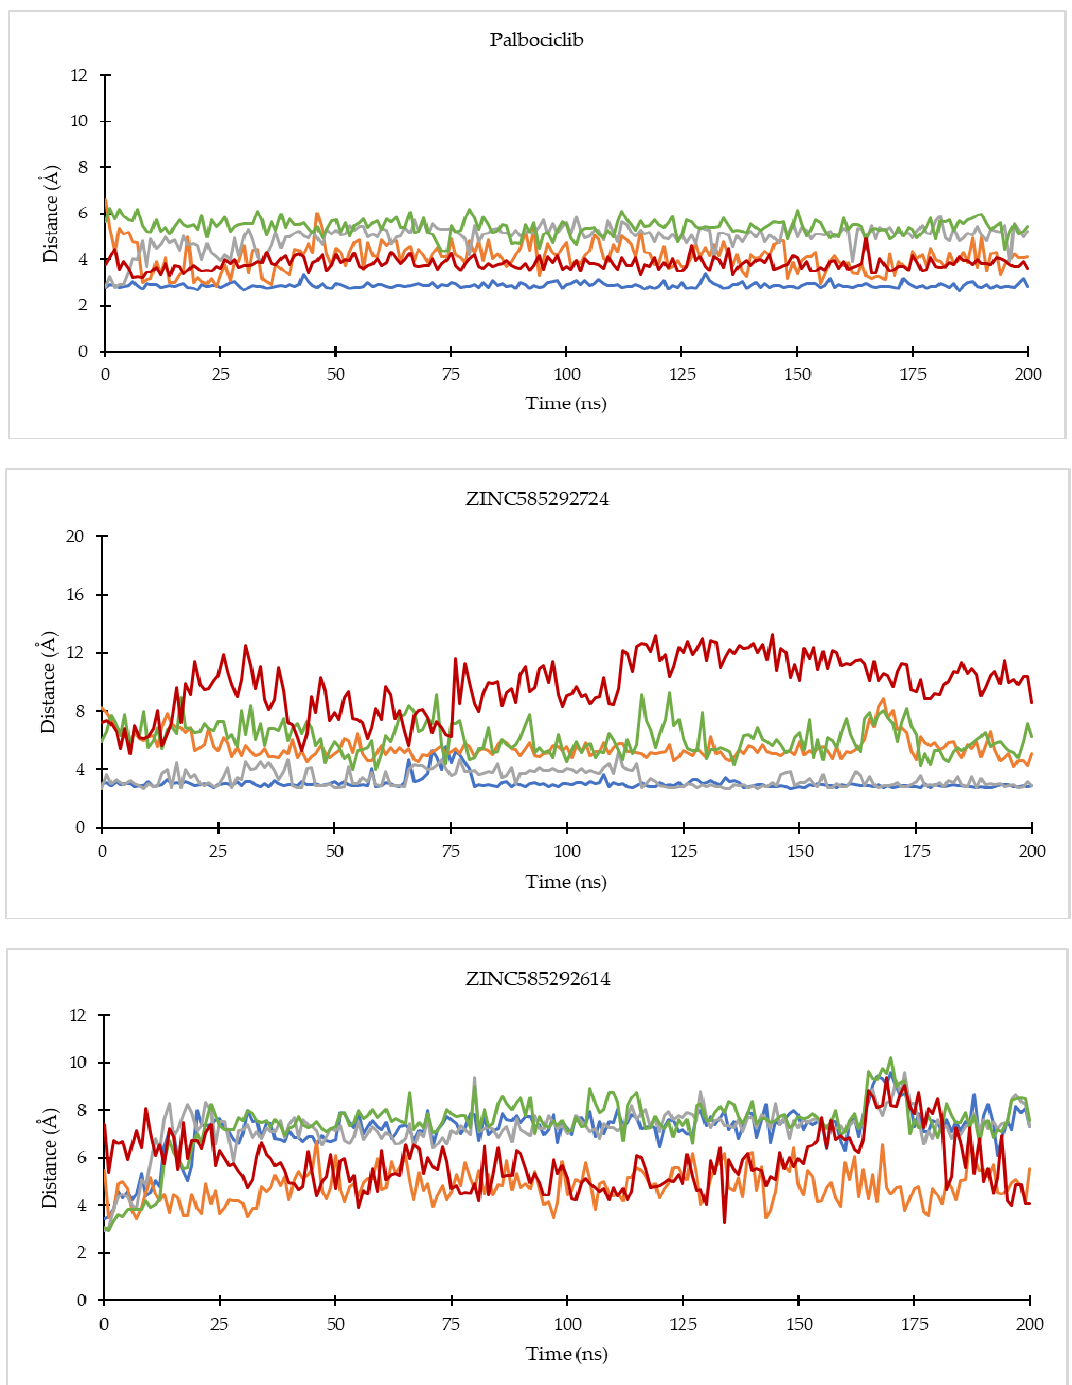
CDK6 (Figure 9), all compounds exhibited distance fluctuations with Asp163 residue. Sig- nificant fluctuations with His100 residue occurred in ZINC585292724 and ZINC585292587 compounds. Significant distance fluctuations occurred in all residues with ZINC257310160, ZINC257203083, and ZINC73097242 compounds. Despite fluctuations in the distance be- tween the hit compounds and residues, all hit compounds persisted inside the ATP-binding pocket of CDK4 and CDK6 during the simulations (see Section